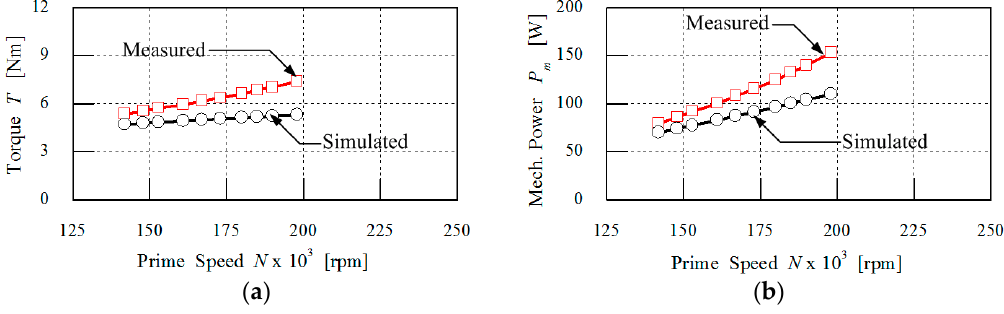
Energies 2016 , 10 , 2 22 of 27 Figure 18. Experimental setup and validation: ( a ) Experimental configuration; ( b ) Test rig. 4.6. Mechanical Power–Speed Characteristics The input mechanical power that rotates the prime rotor of the magnetic geared double-stator PM generator is calculated using Equation (65): (cid:1842) (cid:3040) = 2(cid:2024)(cid:1866)(cid:1846) 60 [W]